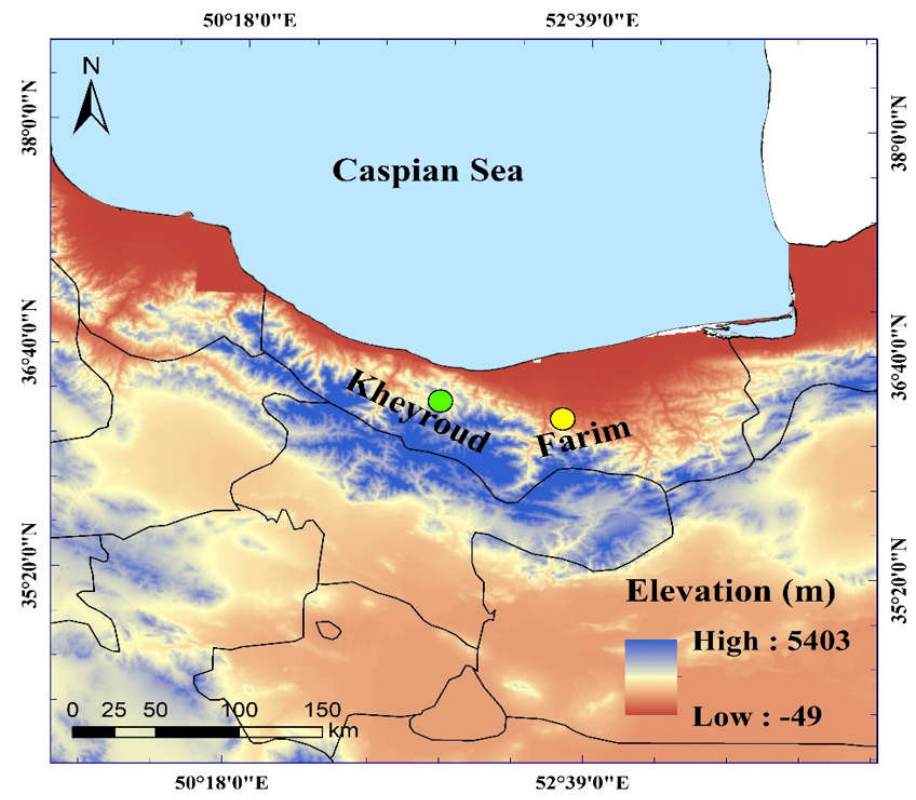
Figure 1. The location of study sites (green and yellow circles) in the Hyrcanian Forest, northern